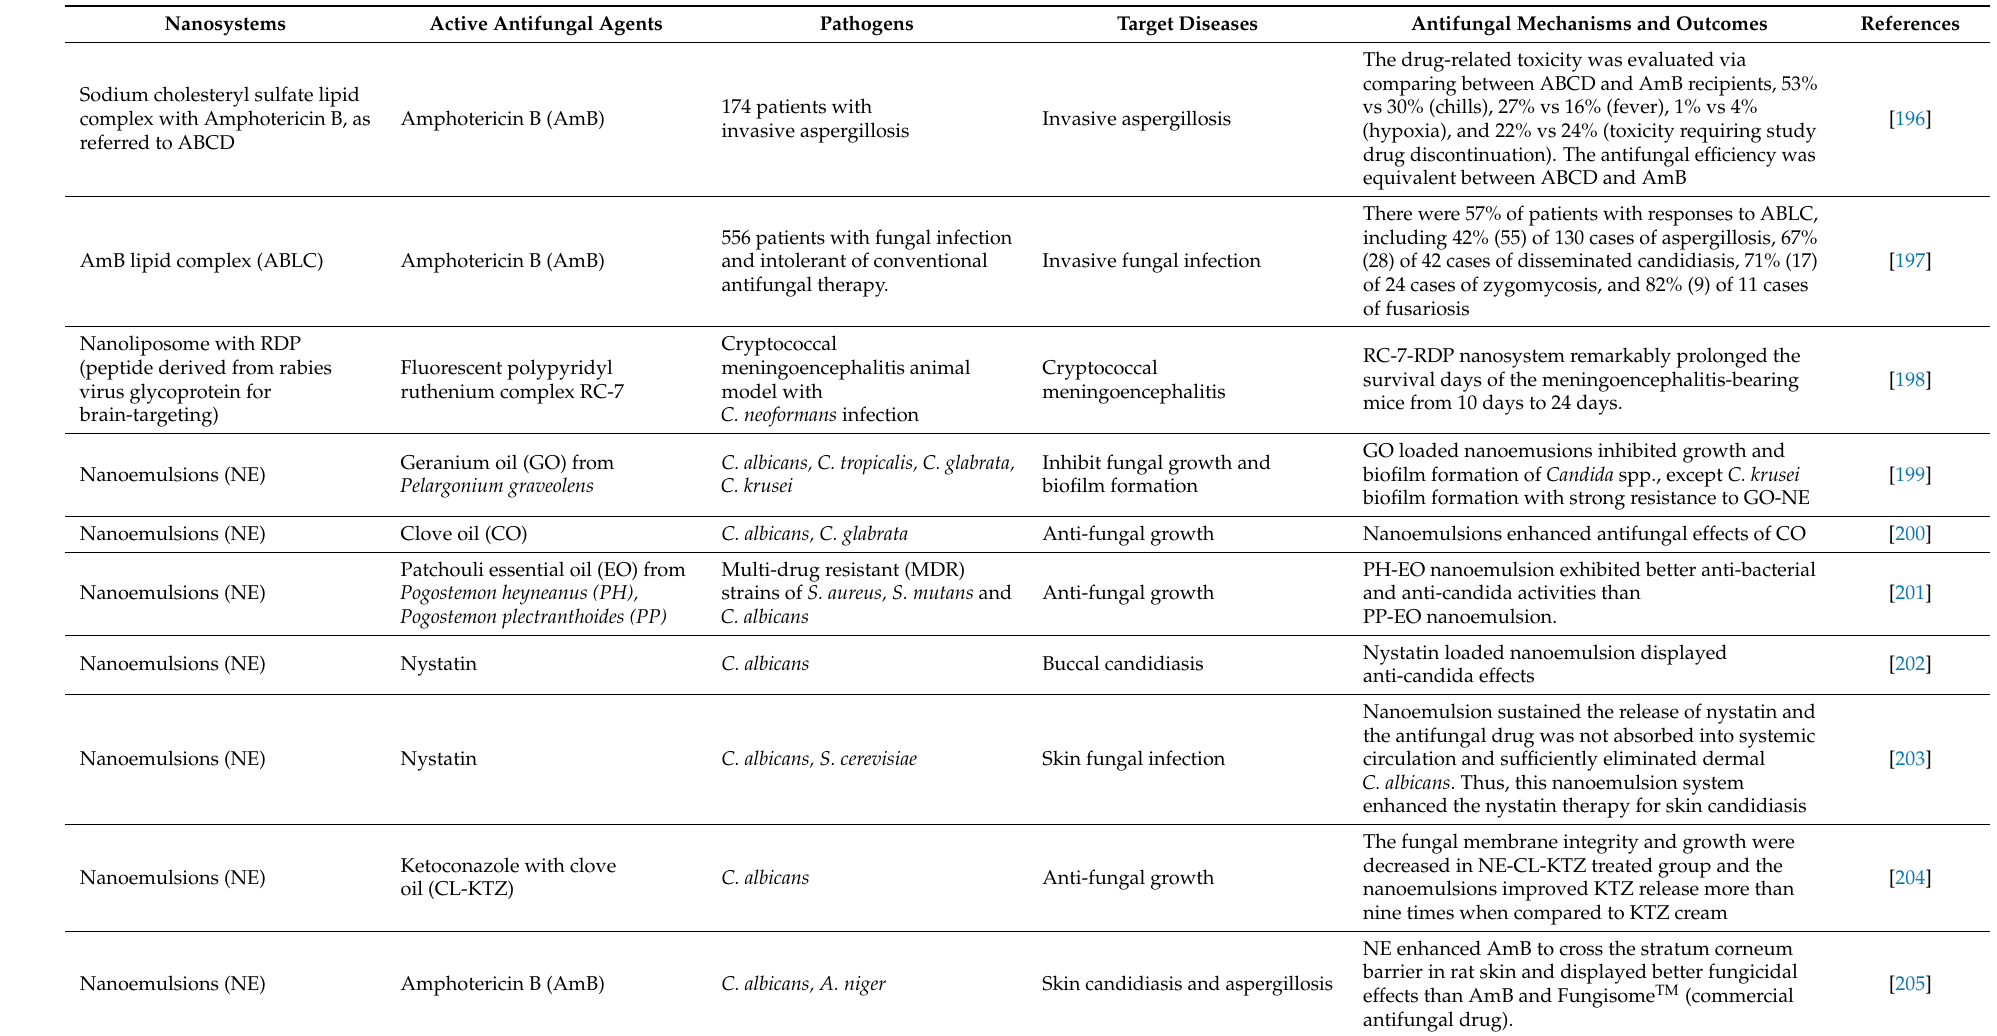
Table 6. Lipid Nanoparticle based antifungal therapeutic